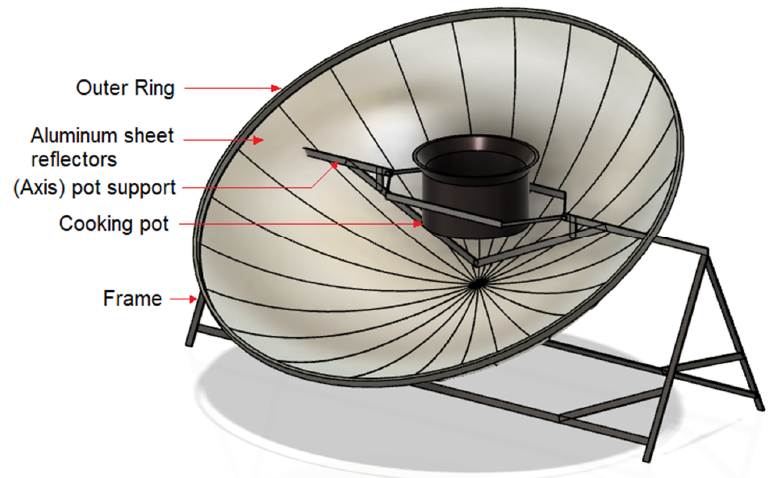
Figure 4. SK14 type parabolic dish-type solar cooker (2020) Mekonnen, Liyew, and Tigabu [69].